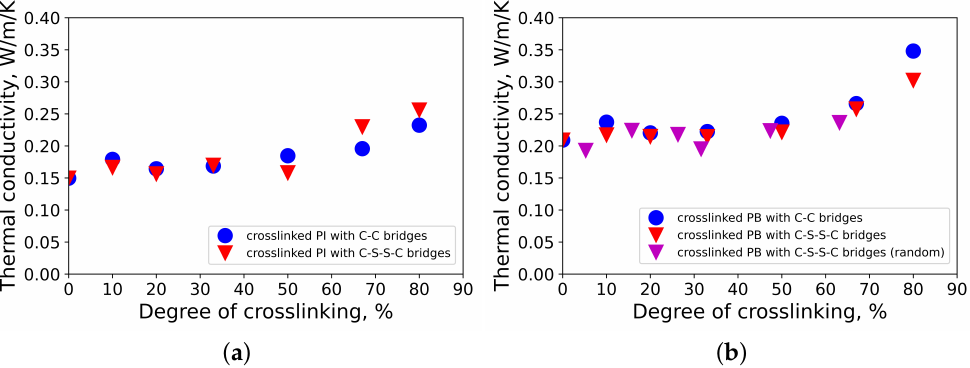
Figure 3. ( a ) Dependency of the thermal conductivity of crosslinked polyisoprene: red triangles and blue circles correspond to structures of vulcanized polyisoprene with C-S-S-C and C-C bridges, respectively; ( b ) dependency of thermal conductivity of crosslinked polybutadiene: red triangles and blue circles correspond to structures of vulcanized polybutadiene with C-S-S-C and C-C bridges, respectively; magenta triangles correspond to models of vulcanized polybutadiene with randomly distributed C-S-S-C